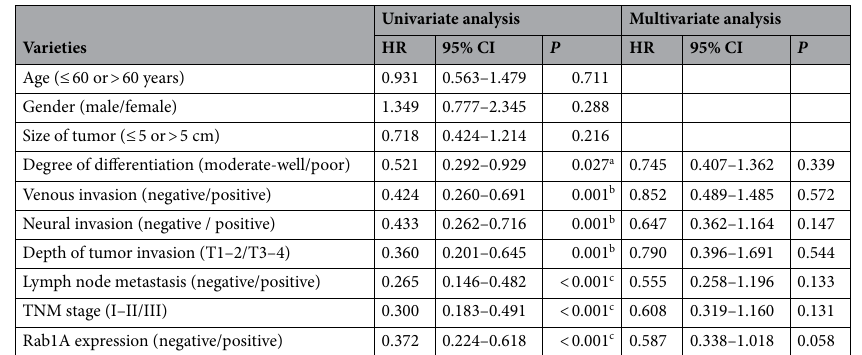
Table 2. Results of univariate and multivariate analyses of postoperative patients’ survival by Cox’s proportional hazard model. a P < 0.05, b P < 0.01, c P < 0.001.